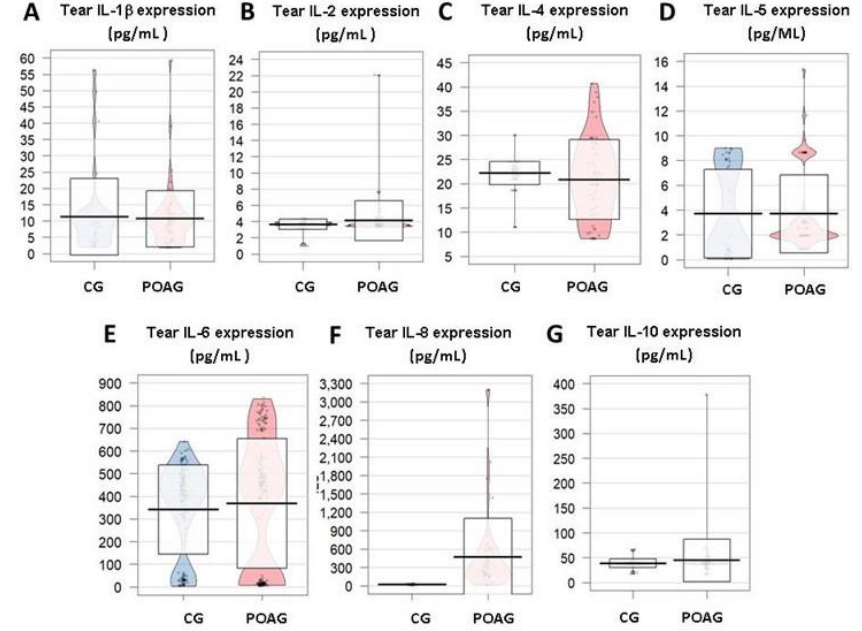
Figure 3. Cytokine expression in tears, aqueous humor, and plasma of glaucoma patients vs. the healthy controls . Differential expression profile of the IL-1β ( A ), IL-2 ( B ), IL-4 ( C ), IL-5 ( D ), IL-6 ( E ), IL-8 ( F ), and IL-10 ( G ) (as expressed in pg / mL). It is observed a statistically significant increase of the chemokine IL-8 as it can be seen in the ( G ), between the POAG vs. the CG tear samples. CG: control group; POAG: primary open-angle glaucoma; IL: interleukin.